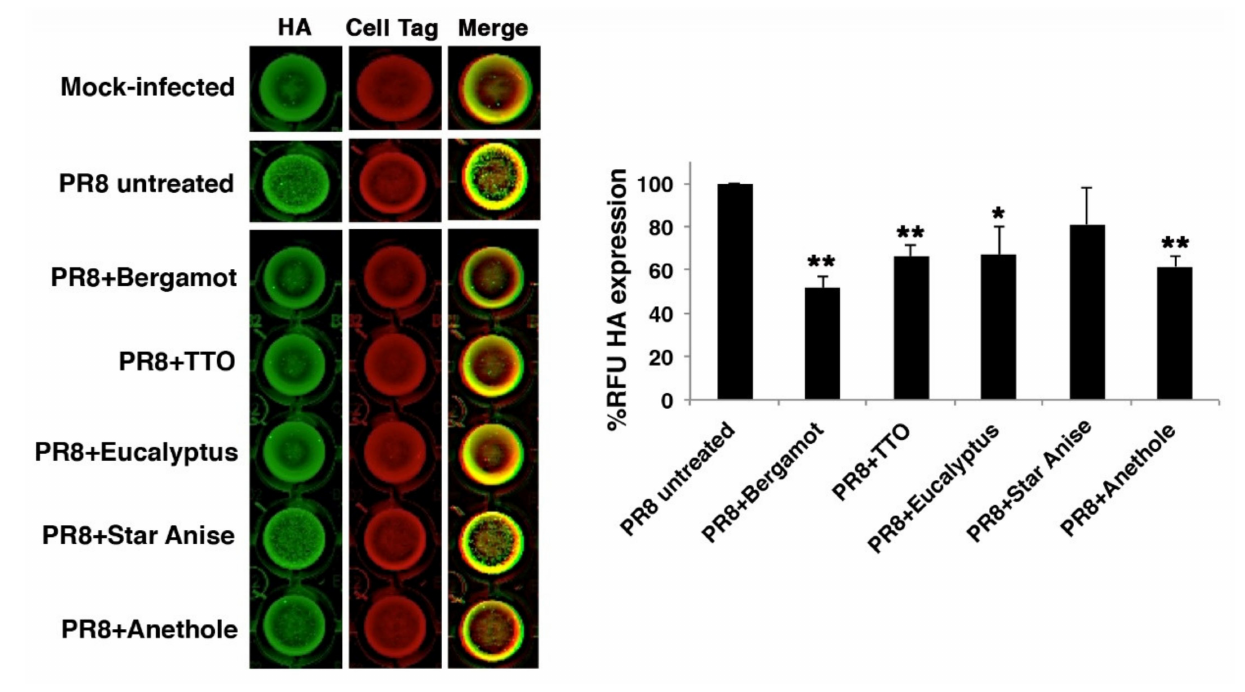
Figure 3. The expression of HA protein was analyzed on MDCK monolayers ( left panel ) by ICW assay using LI-COR Image Studio Software to measure the Relative Fluorescence Units (RFU) ( right panel ). The graph represents the percentage (%) of RFU calculated in cells infected with PR8 treated with different vapor EOs compared to that of PR8 untreated-infected cells (considered 100%). The values represent the mean ± S.D. of three technical replicates performed ( n = 3). Statistical significance of data vs. PR8 untreated-infected cells was defined as * p < 0.05 and ** p <